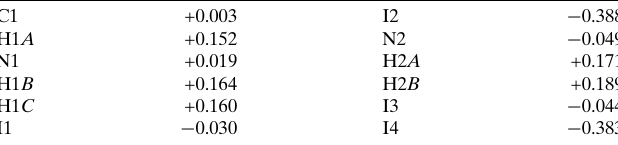
Table 4 Atomic charges calculated using Mulliken population